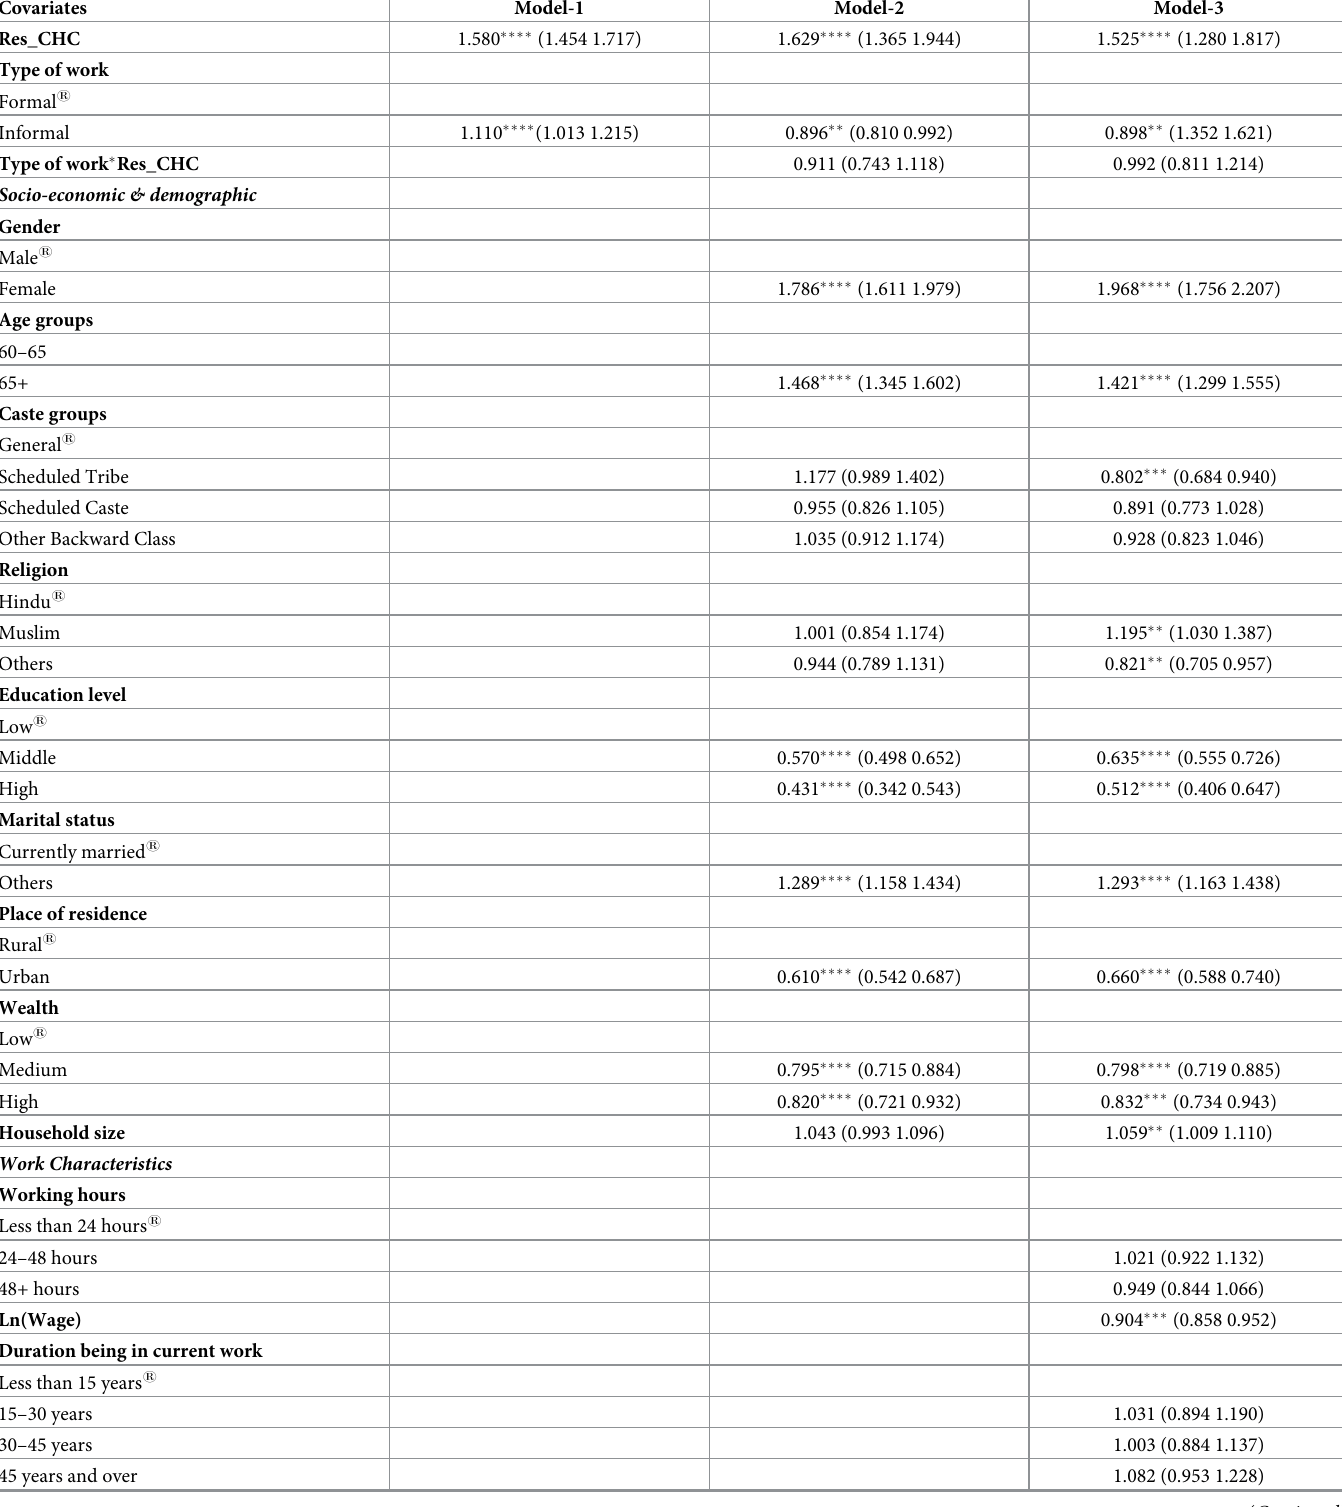
Table 5. Odds of multiple logistic regression for